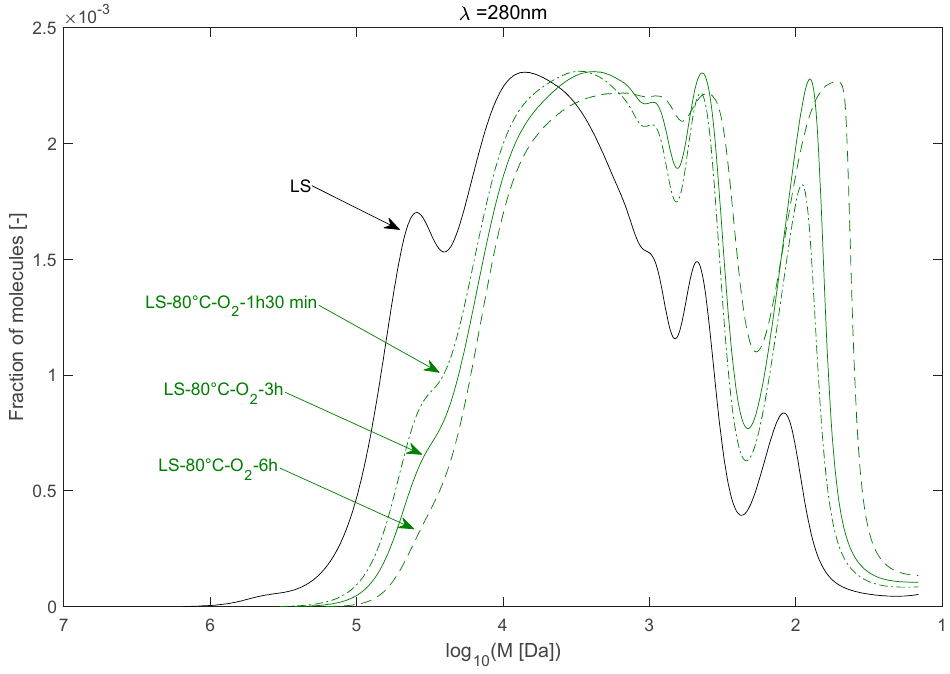
Figure 5. Molecular weight distribution of raw and depolymerized LS as a function of the reaction time (T = 80 °C).